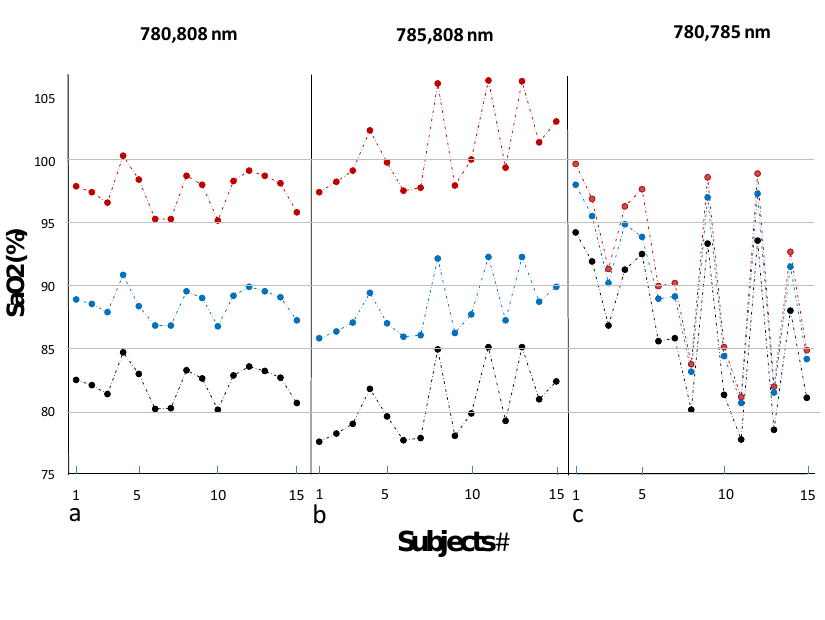
Figure 9. SpO values for the three pairs of wavelengths, determined by using the 2 extinction coefficient data obtained by Zijlstra ( red) Prahl ( black) and Cope